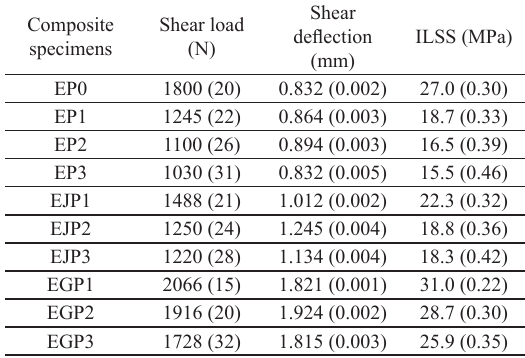
Table 3. ILSS characteristics of EP composites, EJP, and EGP hybrid